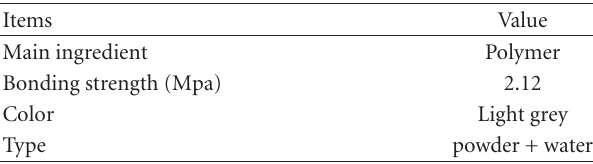
Figure 3: Schematic end result of the RCM test on fractured spec- imen, with di ff erent notation codes. Table 2: Material properties of coating material